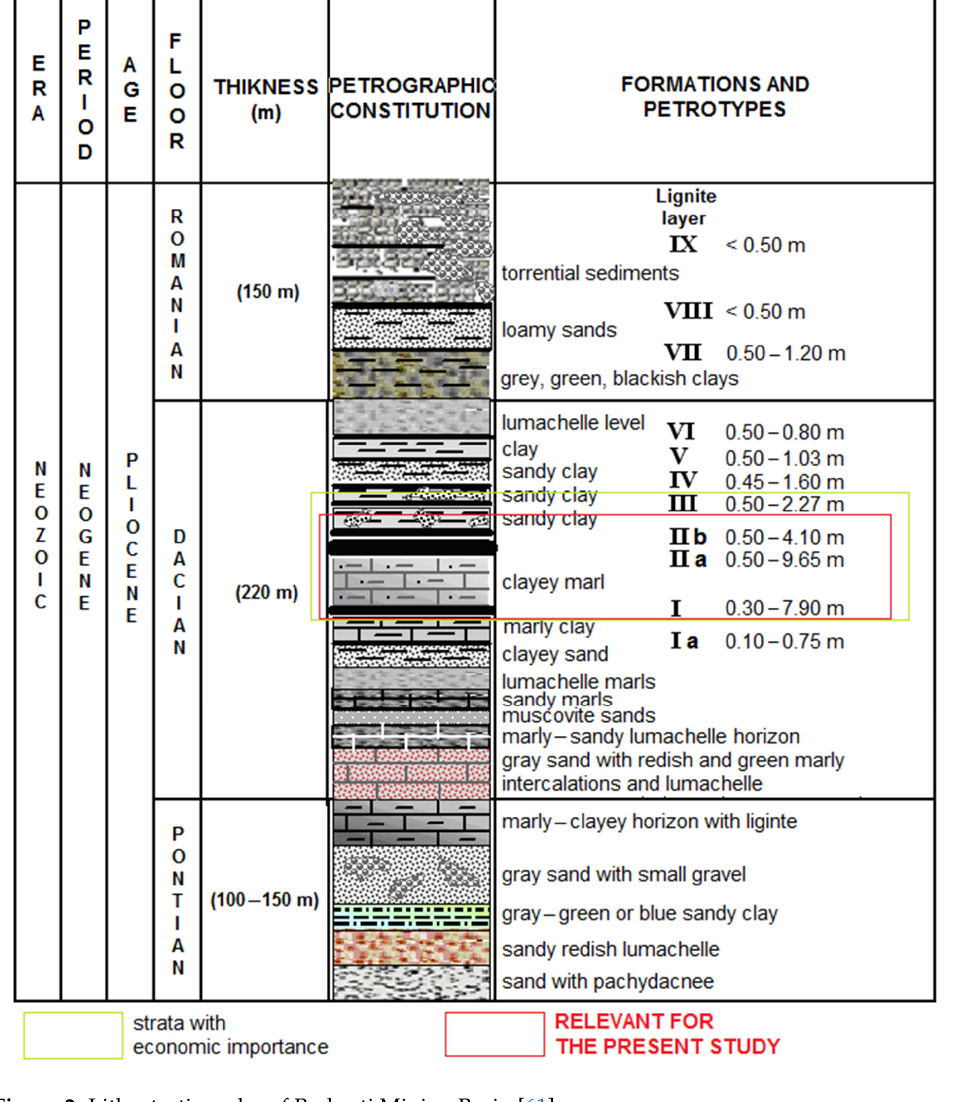
Figure 2. Lithostratigraphy of Berbe ş ti Mining Basin [61].